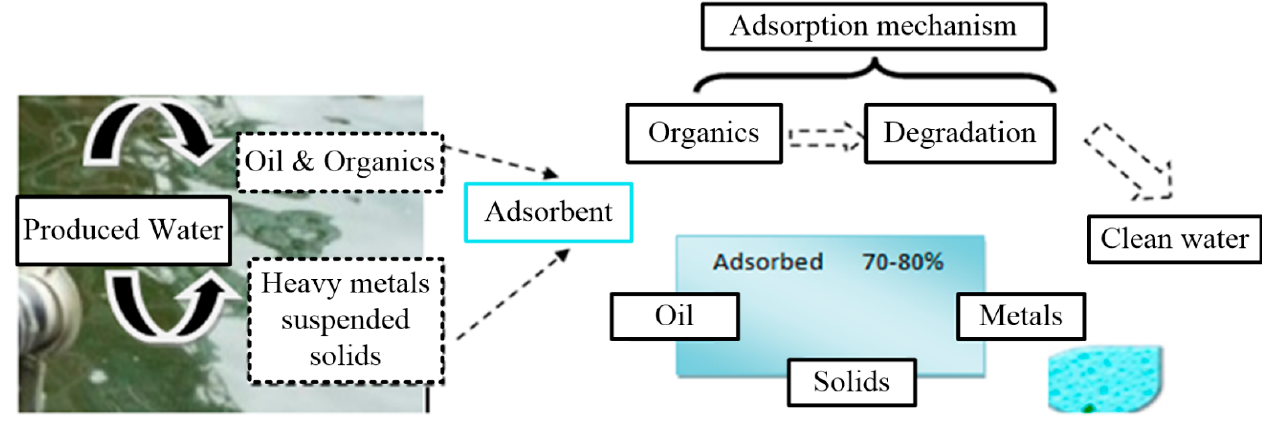
Figure 4. Adsorption mechanism for produced water